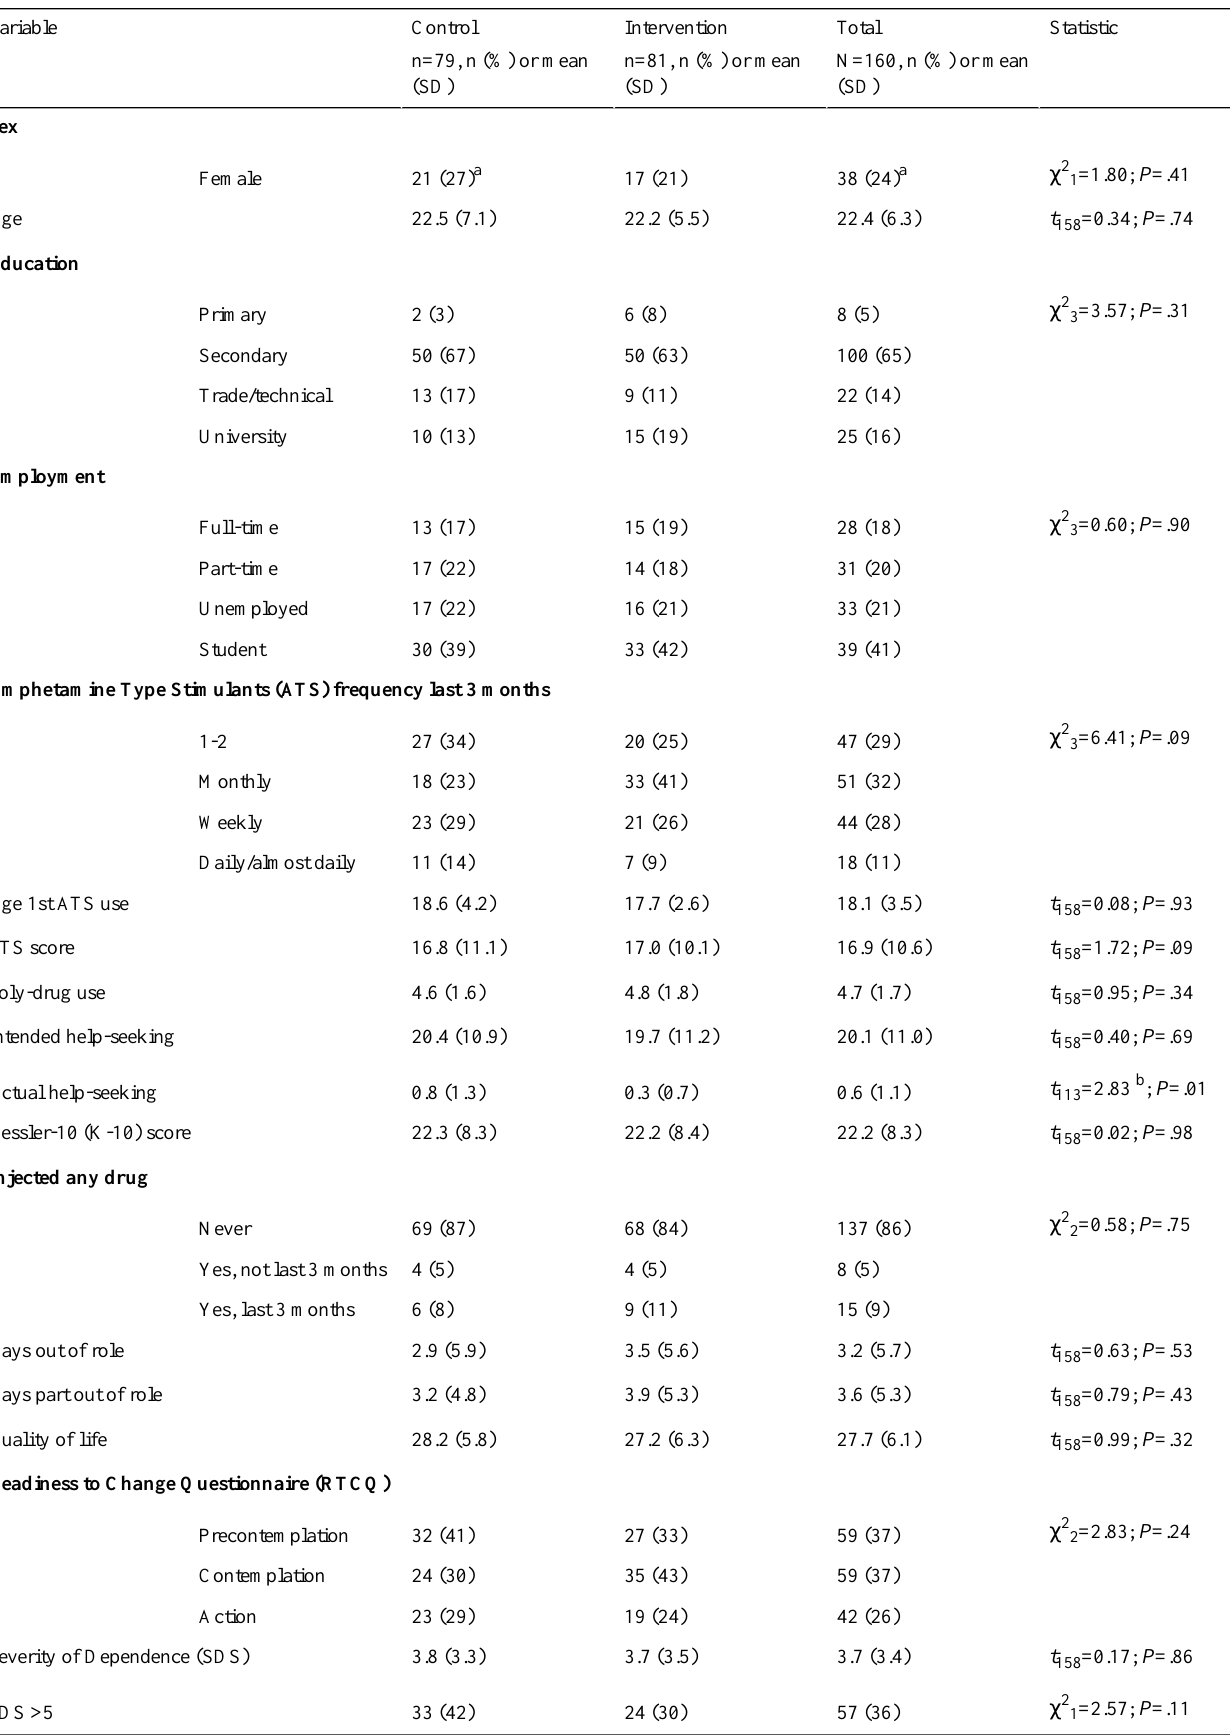
Table 1. Baseline characteristics by study group and